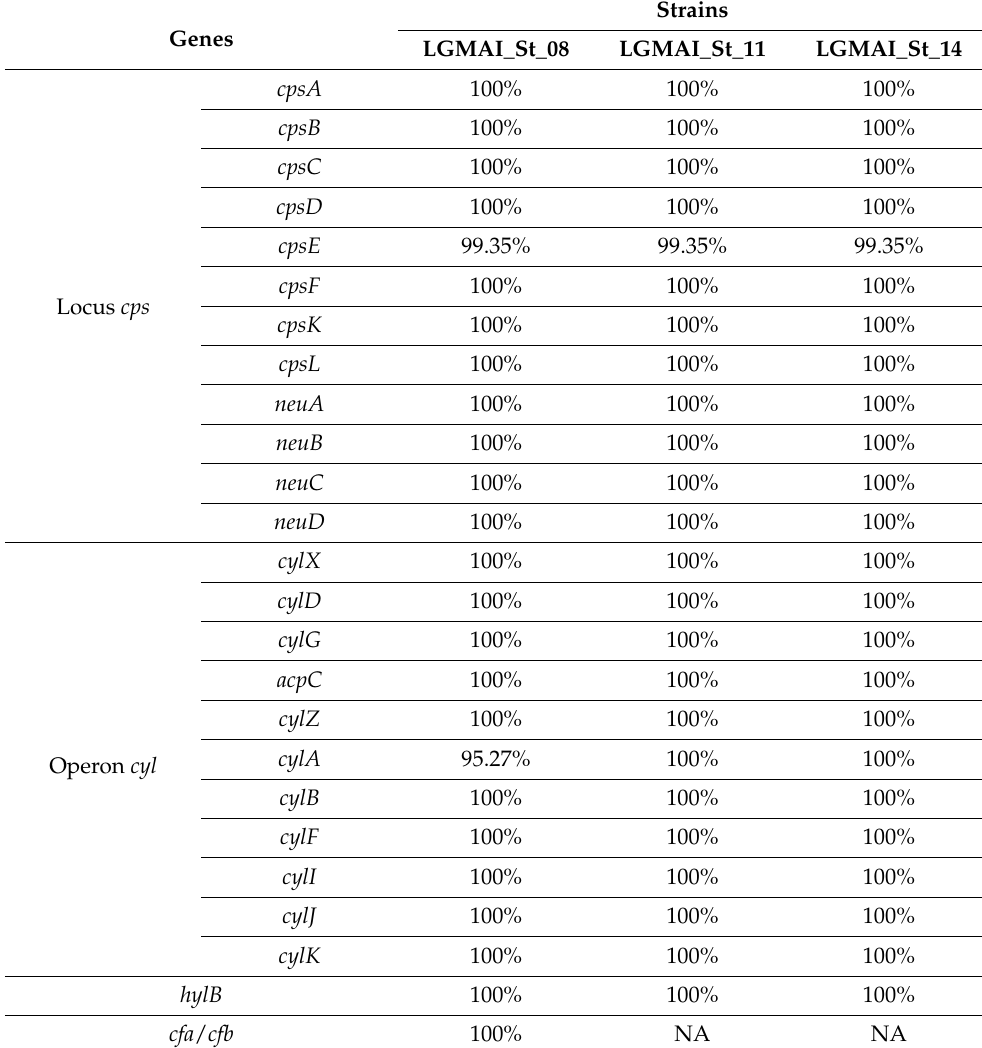
Table 8. Virulence genes identified by the Virulence Factor Database. The cpsE gene had a coverage of 99.35%. All other genes showed 100% coverage. Percentages shown in the table represent gene identities per